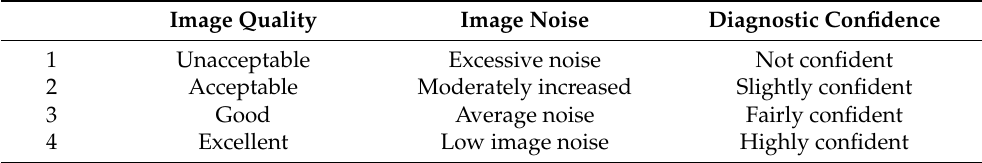
Table 2. 4-point Likert scale for subjective SPECT/CT image quality. Image